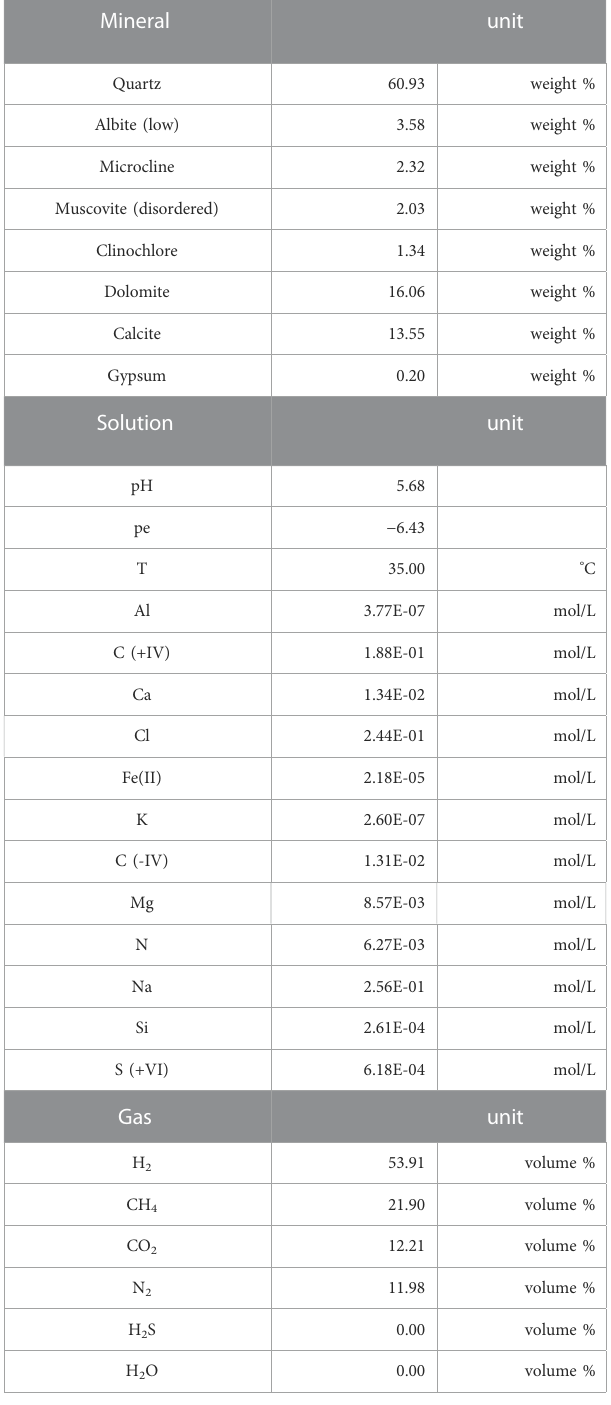
TABLE 4 Model input parameters for application at Lobodice gas